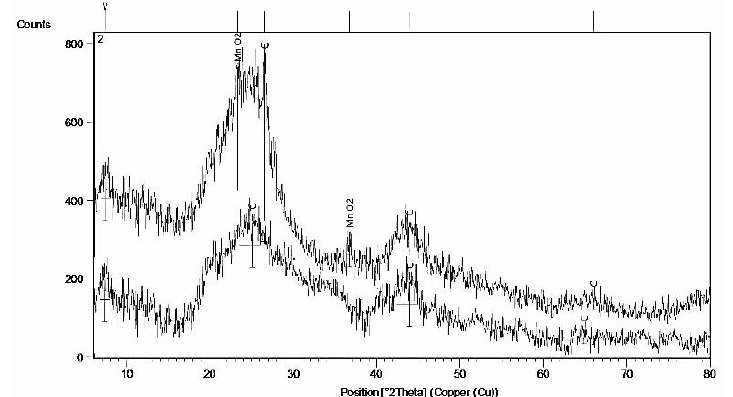
Fig. 4. X-ray diffraction (XRD) patterns of raw and impregnated active